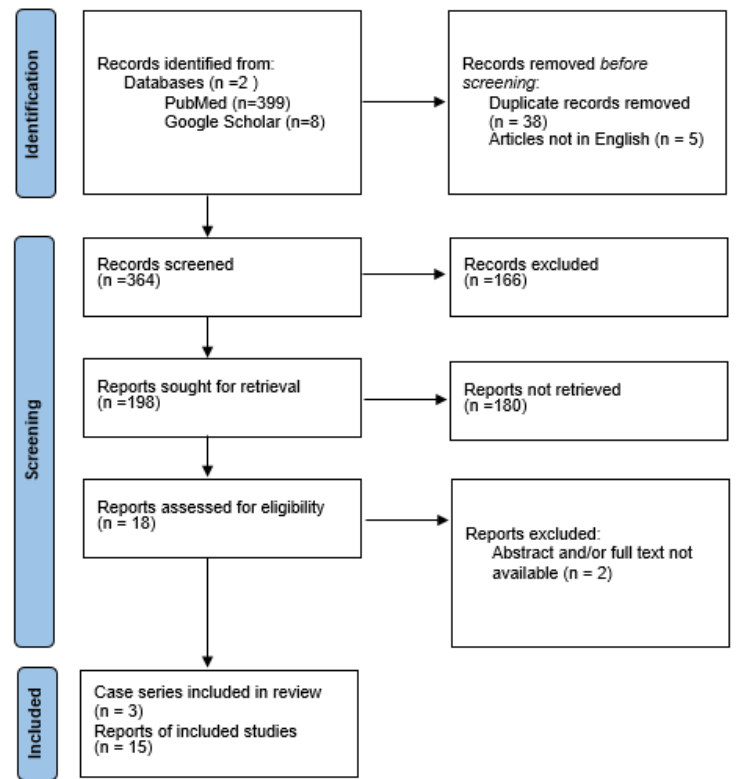
Figure 1. Flowchart of the literature research.